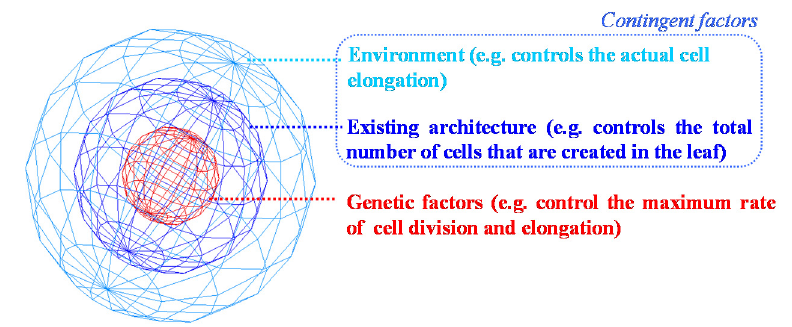
Figure 6. Putative nested levels of control determining ryegrass leaf length. Genetic factors regulate upstream processes that are modulated by lower contingent factors (adapted from